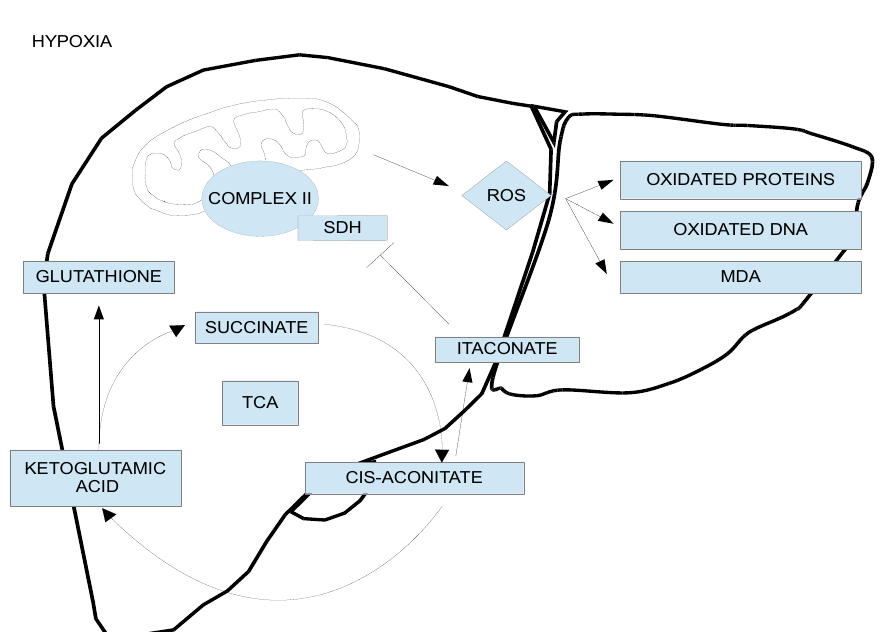
Figure 1. Intracellular mechanisms of ischemic injury. The lack of oxygen to the preserved graft during cold storage provokes a mitochondrial switch to anaerobic metabolism with the interruption of electron flow and mitochondria machinery, the accumulation of interacting energy metabolites succinate and itaconate, and rapid adenosine-triphosphate breakdown. These events that occur during graft cold preservation are modulated by organ preservation solutions. When oxygen is reintroduced under hypothermic oxygenated perfusion and/or with further normothermic conditions, mitochondria re-establish the electron flow with rapid and suitable consumption of the accumulation of succinate at the end of cold ischemia. Subsequent release of reactive oxygen species from complex I occurs. Mitochondria and energy breakdown appear, therefore, as the main targets not only to improve graft quality but also to identify a valid biomarker to predict the “graft status” after static cold storage in organ preservation solutions just before transplantation procedures.